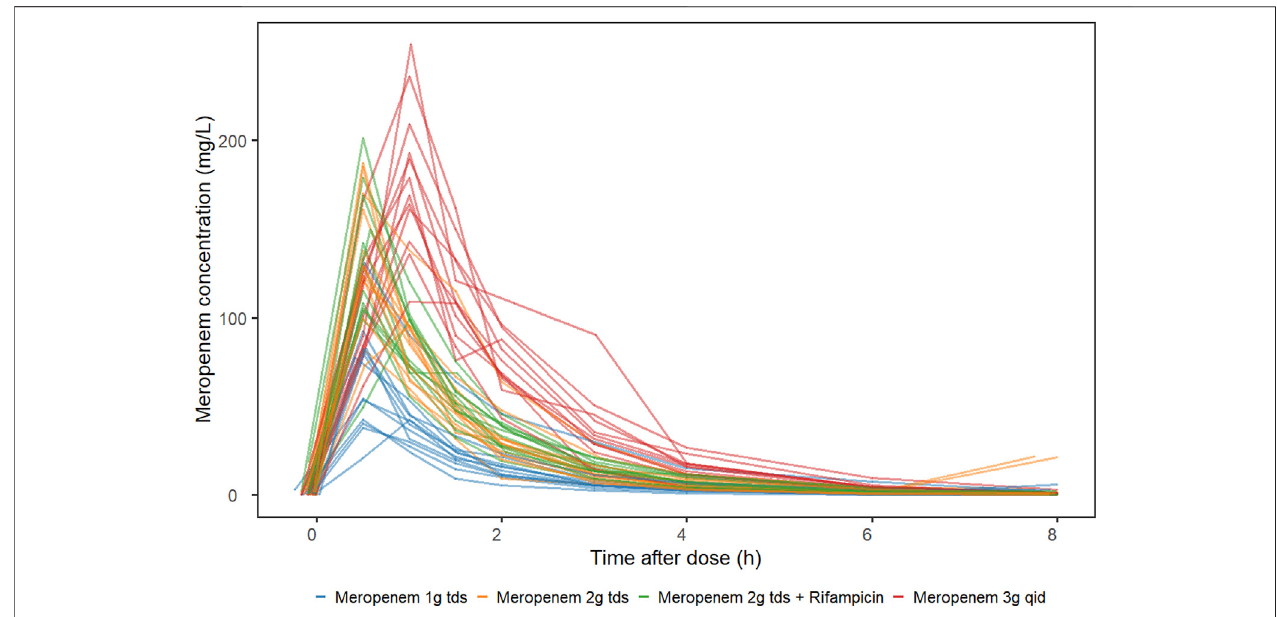
FIGURE 1 | Meropenem plasma concentration-time pro fi le strati fi ed by study arm. MACR2X3, intravenous meropenem 2 g three times daily plus oral rifampicin 20 mg/kg once daily; MAC2X3, intravenous meropenem 2 g three times daily; MAC1X3, intravenous meropenem 1 g three times daily; MAC3X1, intravenous meropenem 3 g once